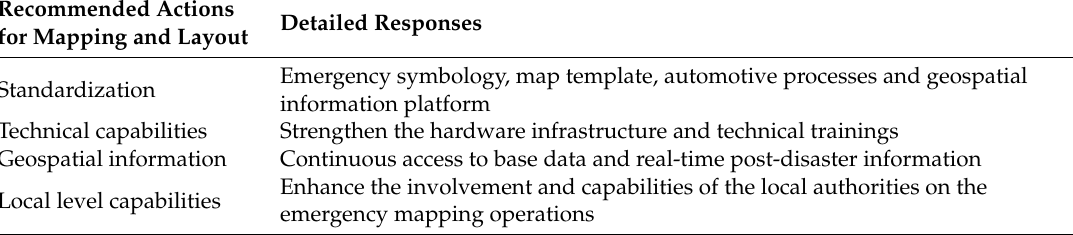
Table 7. Recommendations for EIGEO mapping and layout (d) (Q33).